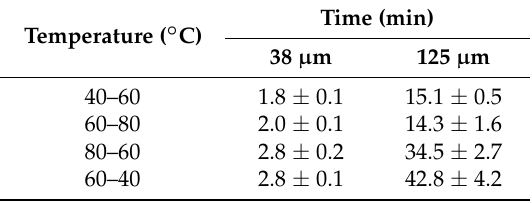
Table 1. Stabilization time (in minutes) of electrical capacitance of gelatin sensor with 38 µm (868 MHz) and 125 µm (600 MHz). All data are presented as average values ± standard deviations (sample size = 3).